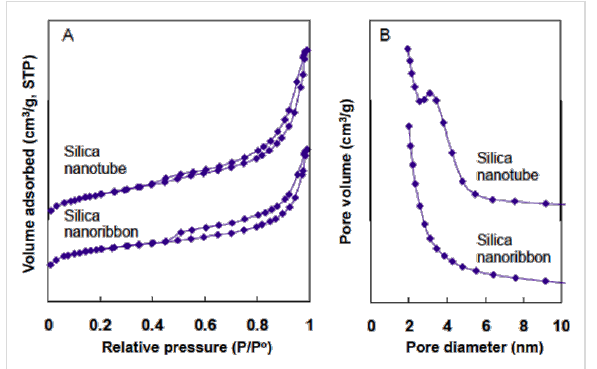
Figure 2: N 2 adsorption/desorption isotherms (A) and BJH pore-size distribution curve obtained from the adsorption branch (B) of silica nanoribbon and silica nanotube. The synthesis conditions are the same to that of the samples shown in Figure 1. The sample was calcined at 800 °C in air for 3 h with at heating rate of 2.5 °C per